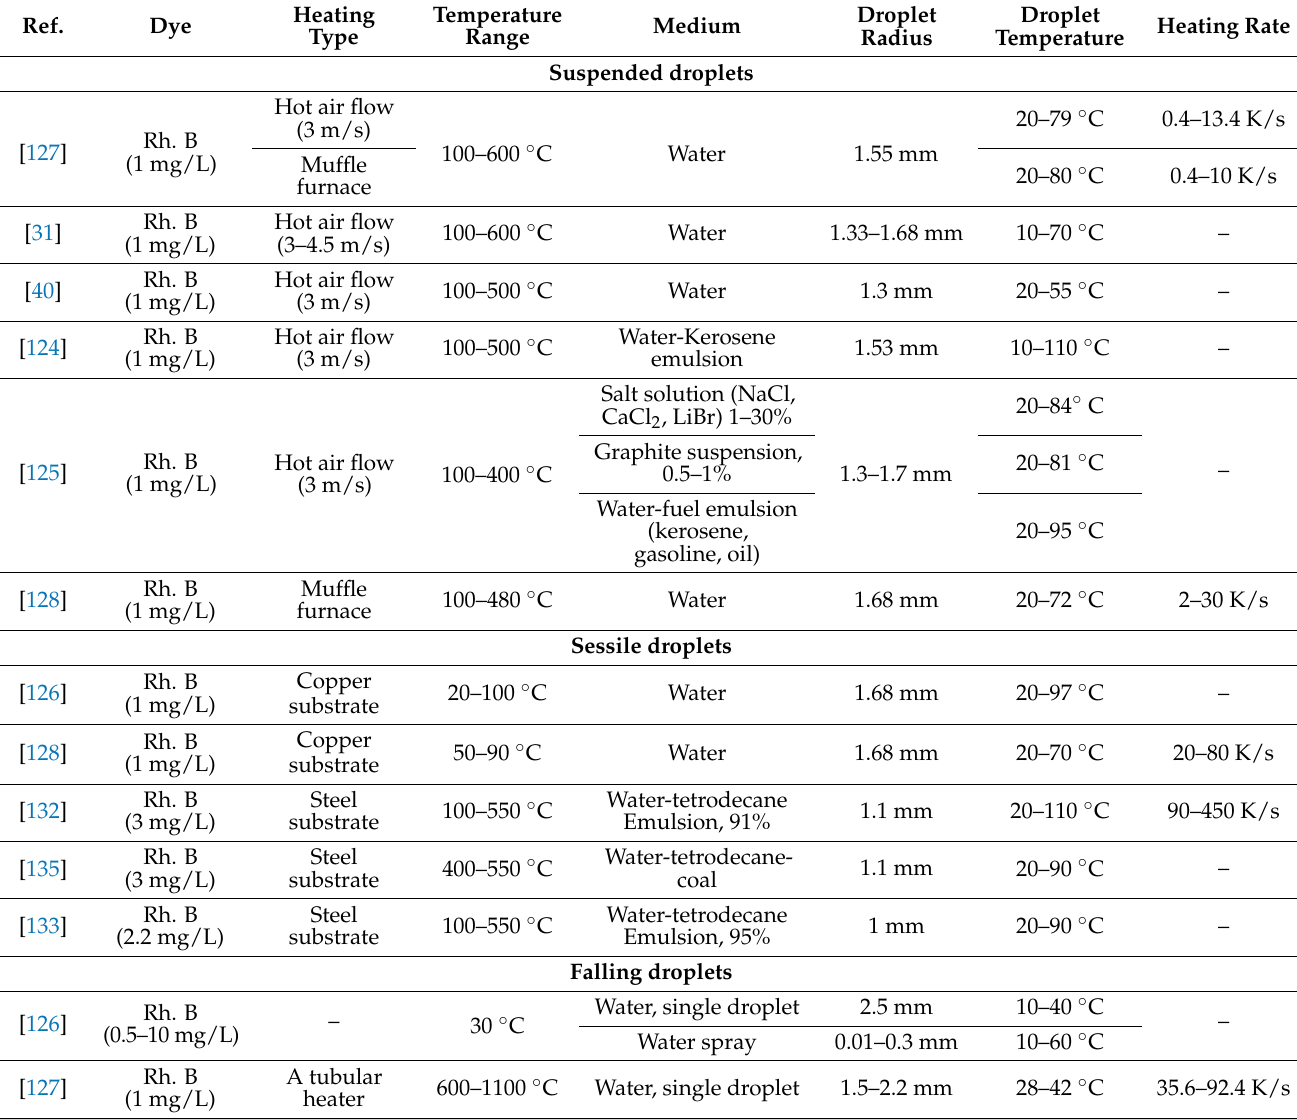
Table 2. The main achievements in the field of using PLIF to study the processes of heat and mass transfer in the systems “liquid droplet—gas” and “liquid droplet—solid wall”.